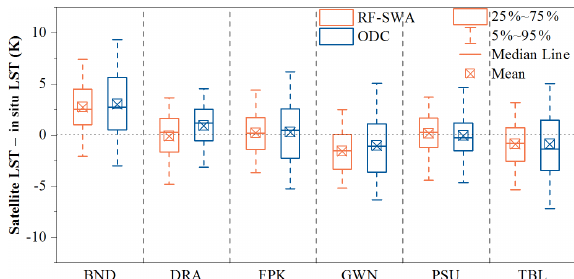
Figure 10. Residuals with respect to in situ LST for ODC and RF- SWA LST for six SURFRAD sites (BND, DRA, FPK, GWN, PSU, and TBL). Details about the sites are provided in Table